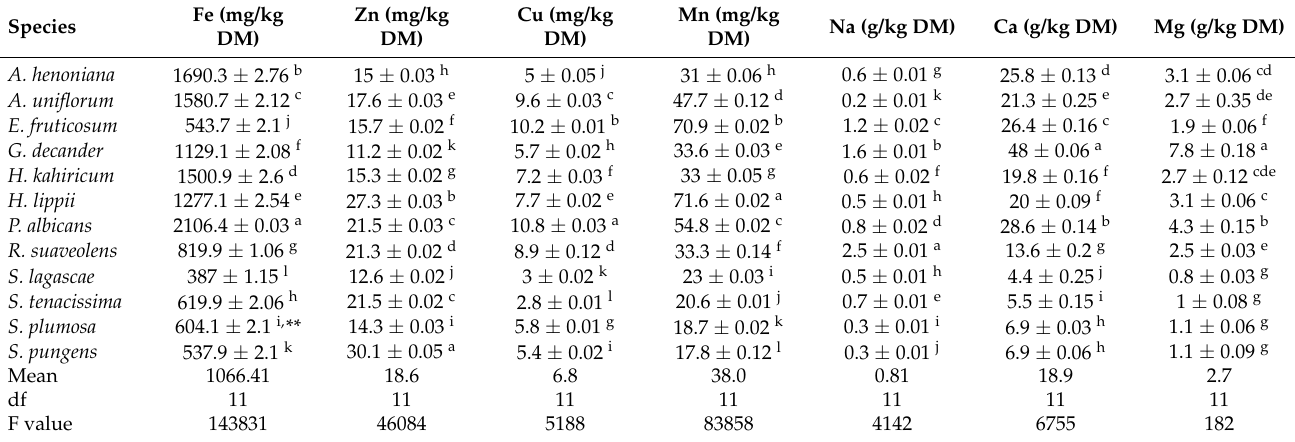
** Means in a column with different letter(s) differ ( p <